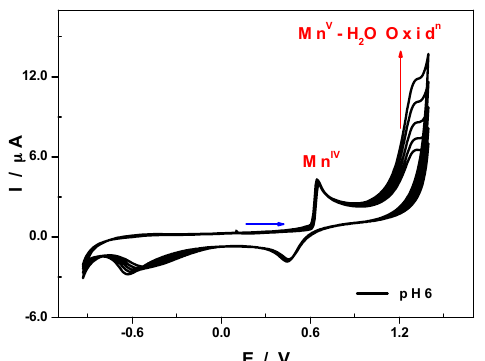
Figure 7. CV of 1 in 1.0 M CH 3 COOLi + CH 3 COOH/pH 6. Polyoxometalate concentration: 0.5 mM; scan rate: 10 mV · s − 1 ; working electrode: glassy carbon; reference electrode: SCE. Potentials were initially scanned from +0.10 V to +1.40 V (Mn 2+/4+ oxidation followed by Mn 4+/5+ and H 2 O electro-catalytic oxidation) then down to − 0.93 V (regeneration of the working electrode surface).